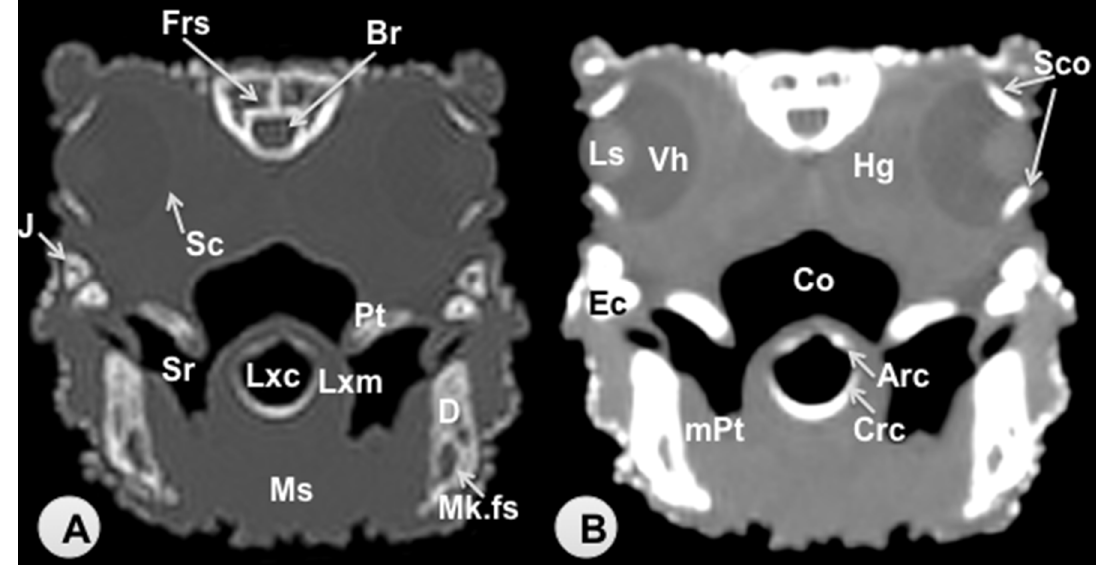
Figure 3. Transverse CT image of the head of Varanus komodoensis at the level of the eyes corresponding to line III. ( A ) CT bone window. ( B ) CT soft tissue window. These images are displayed so that the right side of the head is to the viewer’s left and the dorsal view is at the top. Frs: Frontal sinus. Br: Brain. Sco: Scleral ossicles. Ls: Lens. Vh: Vitreous humor. Hg: Harderian gland. Sc: Sclera. J: Jugal bone. Ec: Ectopterygoid bone. Pt: Pterygoid bone. D: Dentary bone. Mk.fs: Meckelian fossa. mPt: Musculus pterygoideus. Lxc: Laryngeal cavity. Lxm: Laryngeal muscles. Ms: Musculus intermandibularis + Musculus geniohyoideus + Musculus genioglossus + Musculus hyoglossus. Crc: Cricoid cartilage. Arc: Arytenoid cartilage. Co: Cavum oris. Sr: Sublingual recess.